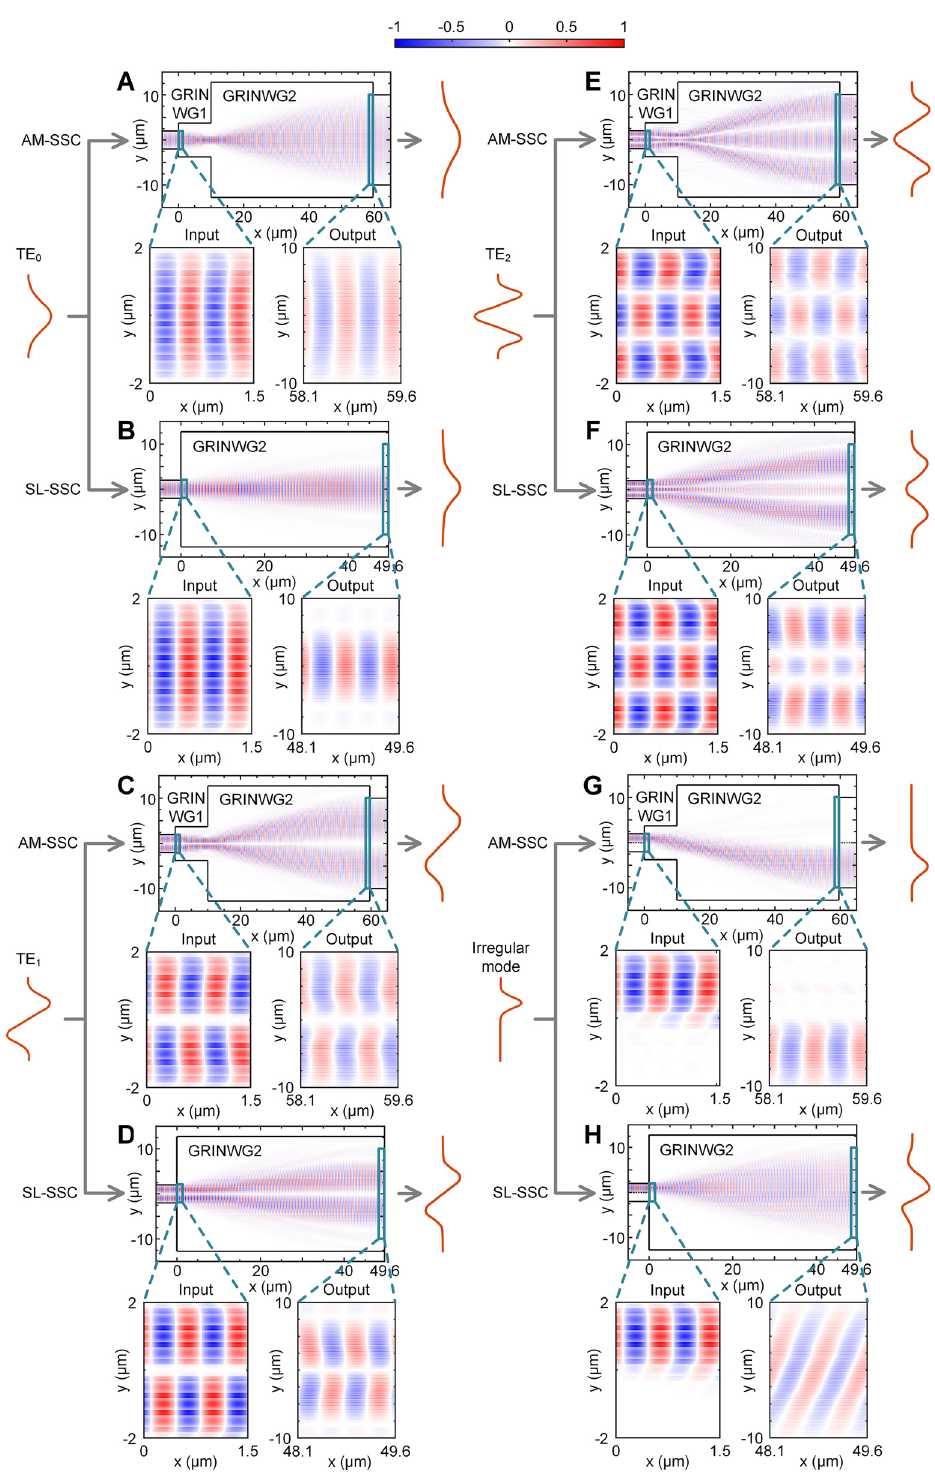
Figure 2: Light propagation profiles ( E y ) inside the AM-SSC and the SL-SSC for various incident modes. Regarding to the AM-SSC, the pro fi les arecalculatedfor(A)TE 0 ,(C)TE 1 ,(E)TE 2 and(G)irregularmodes.Forcomparison,theresultsoftheSL-SSCforthesemodesarealsocalculated in (B), (D), (F), and (H), respectively. Detailed pro fi les at the input and the output port are illustrated as insets. SSC, spot size converter; AM, arbitrary-mode; TE, transverse